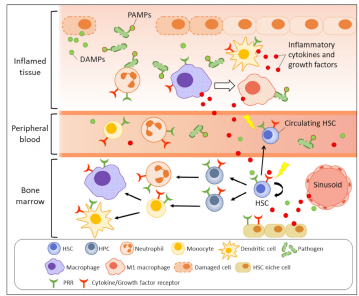
Figure 1. Emergency myelopoiesis triggered by inflammatory signals. Upon infection or tissue damage, the release of PAMPs and DAMPs (green dots) at inflammatory site are recognised by